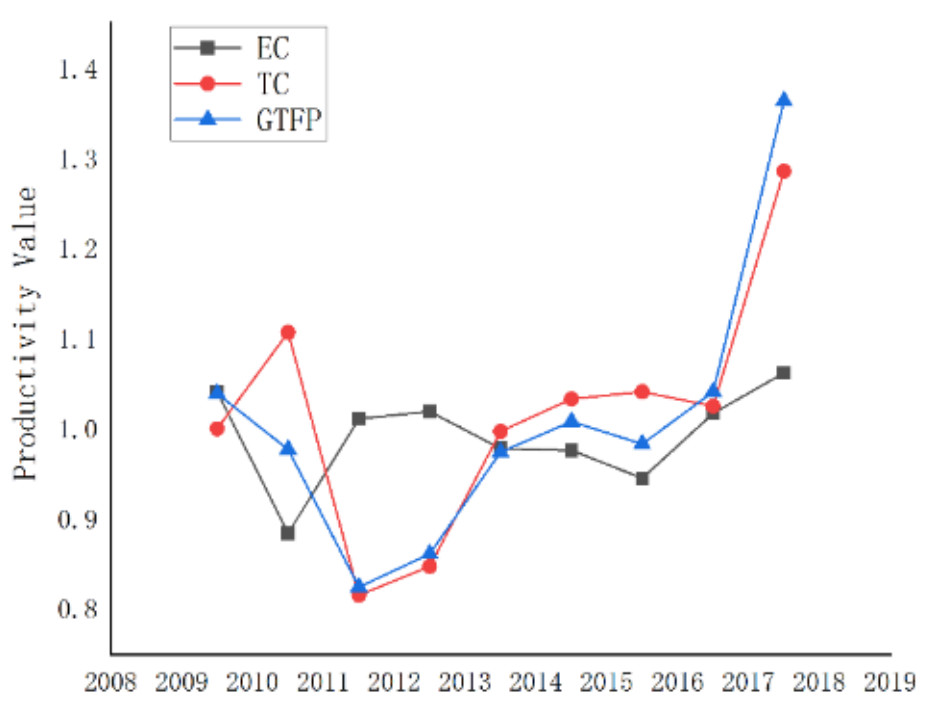
Figure 2. GTFP (Green Total Factor Productivity) and its decomposition (EC, technical efficiency and TC, technological progress) in the YREB (Yangtze River Economic Belt).